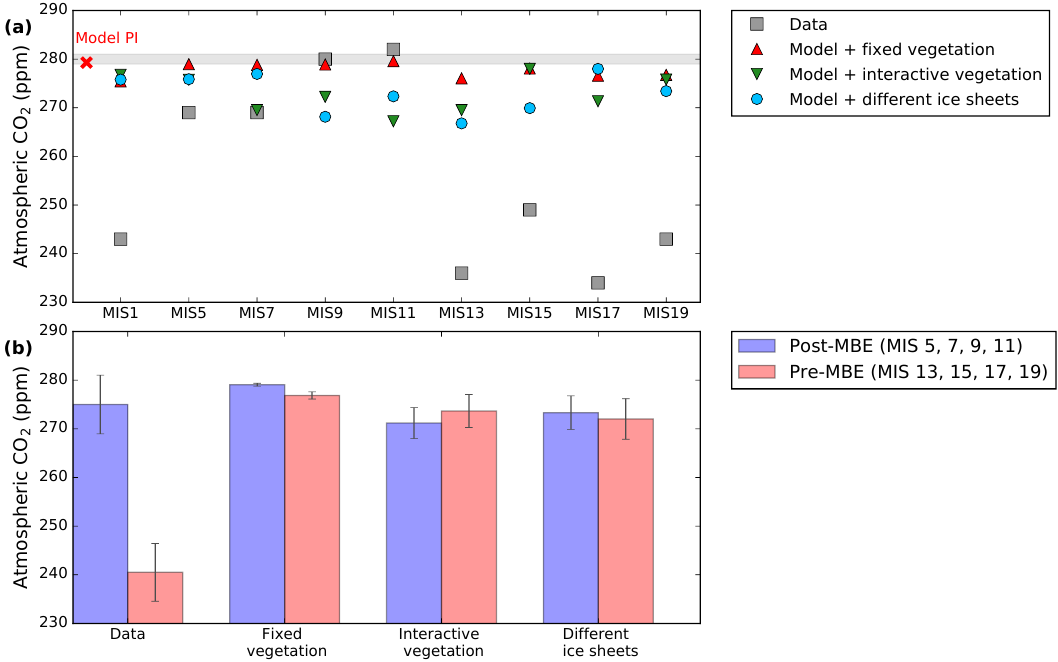
Figure 11. (a) CO 2 concentration (ppm) at the end of the simulations and (b) composite (average) CO 2 (ppm) in the pre-MBE (MIS 13, 15, 17, 19) and post-MBE (MIS 5, 7, 9, 11) interglacial simulations.